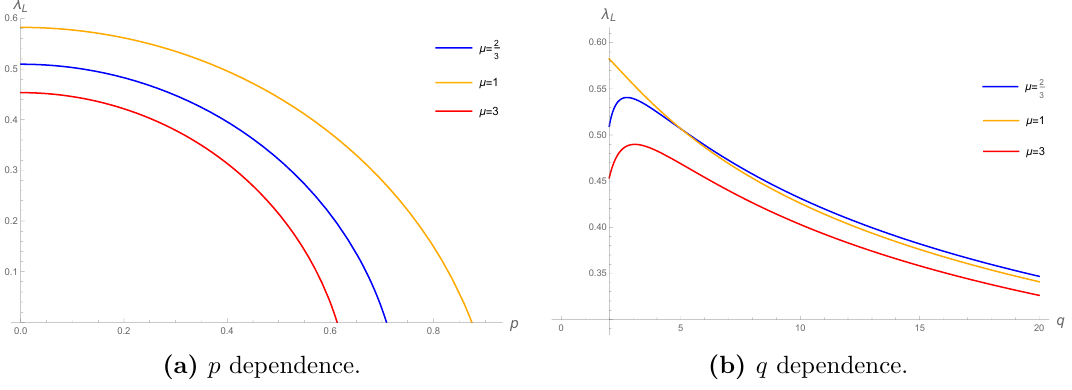
Figure 5. Functional dependence of the Lyapunov exponent (cid:21) L